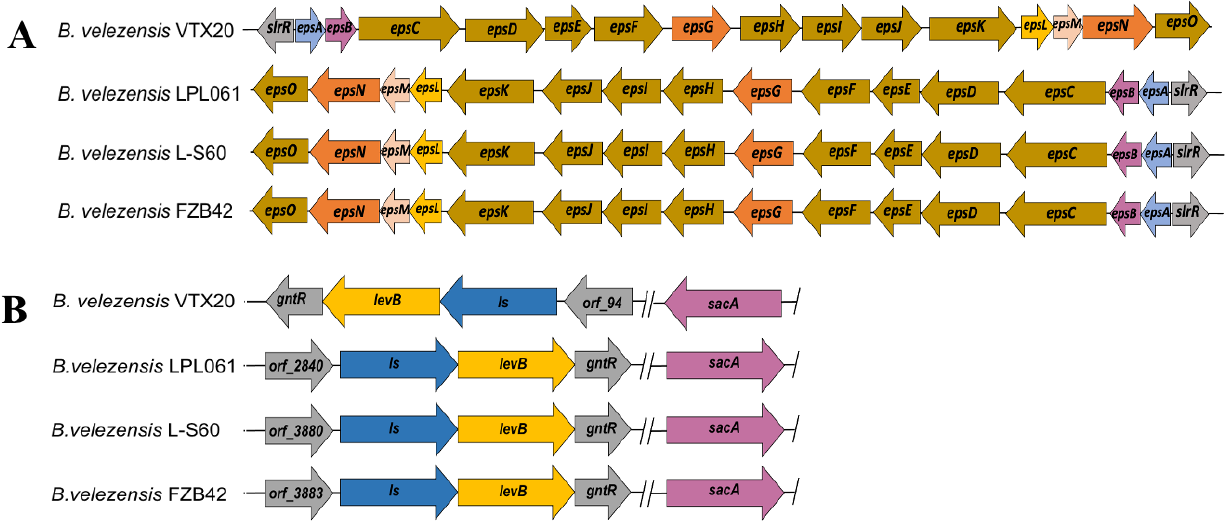
Figure 5. The EPS ( A ) and levan biosynthetic gene cluster ( B ) identified in B. velezensis VTX20.